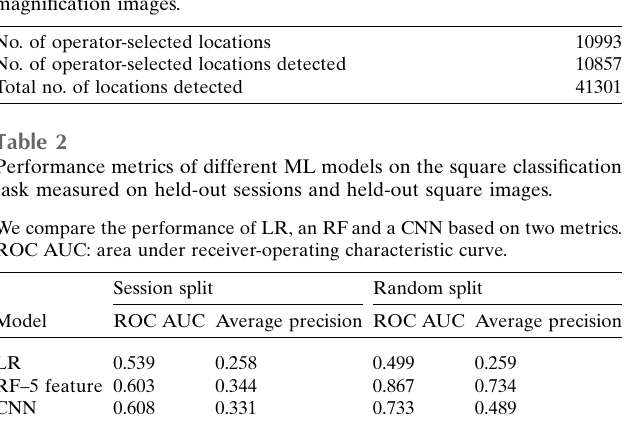
Table 1 Statistics from running the square localization procedure on low- magnification images.